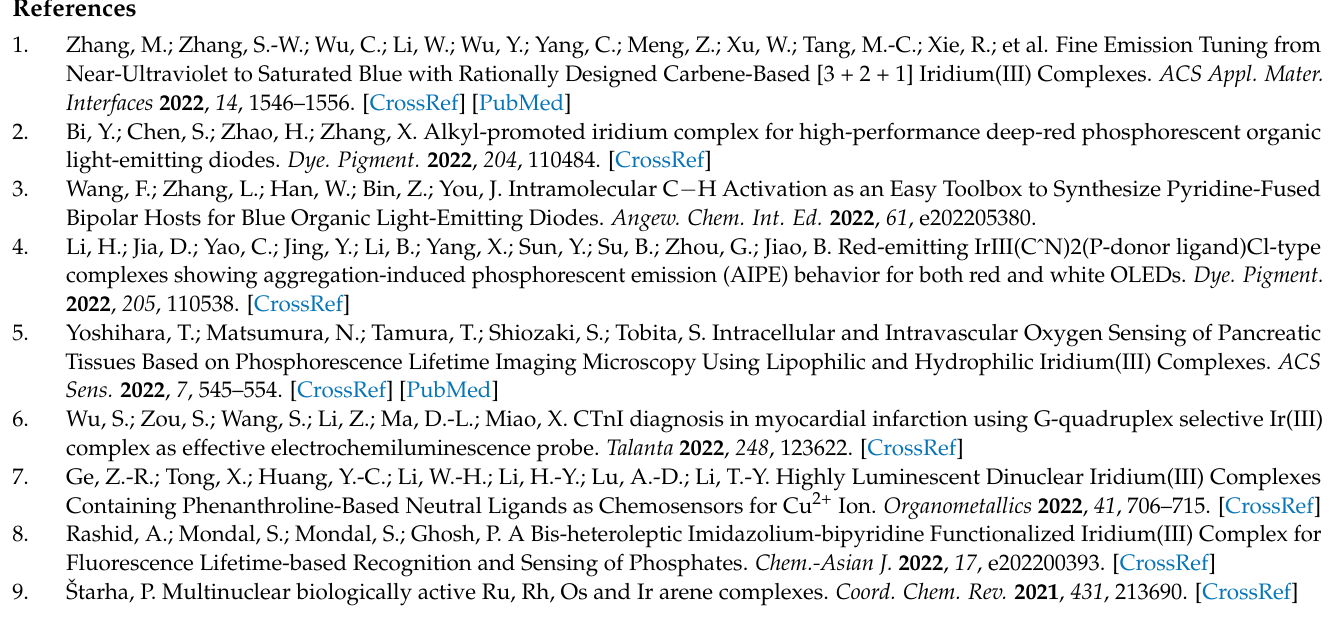
Figure S2. Experimental and calculated PXRD patterns for complex 2 ; Figure S3. FTIR spectrum of complex 1 ; Figure S4. FTIR spectrum of complex 2 ; Figure S5. 1H NMR spectrum of complex 1 in DMSO-d6 at 500 MHz; Figure S6. Photograph of the single crystals of compound 2 in the